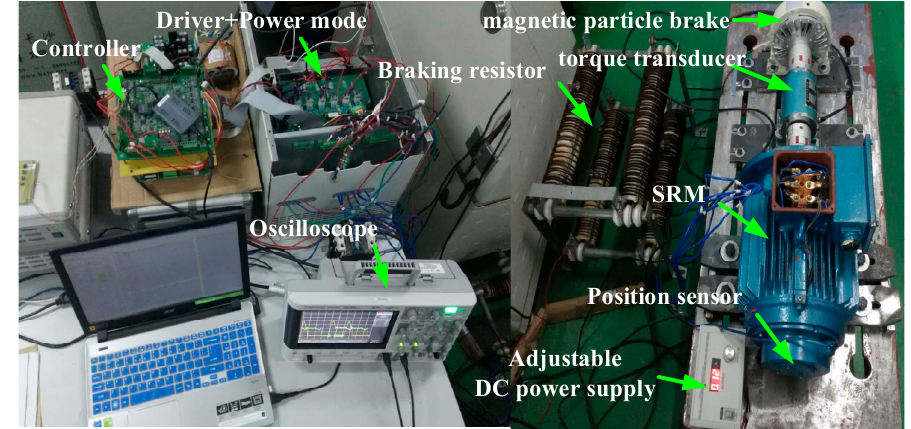
Figure 21. Experimental setup of the 12/8 SRM drive system.